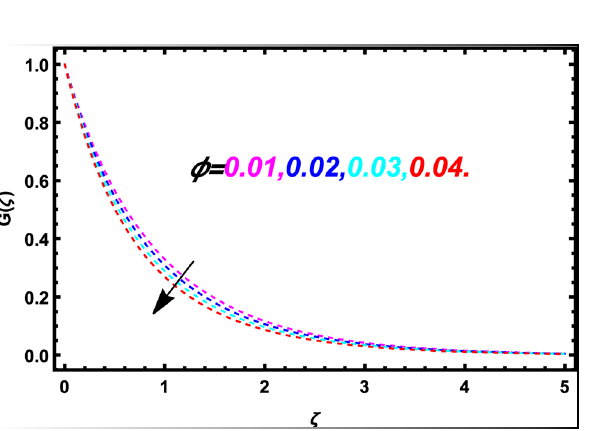
Figure 15. Demonstration of velocity curve versus φ when Fr = 0.2, k 1 = 0.1, k 2 = 0.3, M = 0.5, m = 0.2, Pr = 5.3, Ec = 0.3, ε Rd = 0.2, Sc = 0.1, ε Lb = 0.3, Pe = t = 3.0, C = 3.0, δ = 0.3,